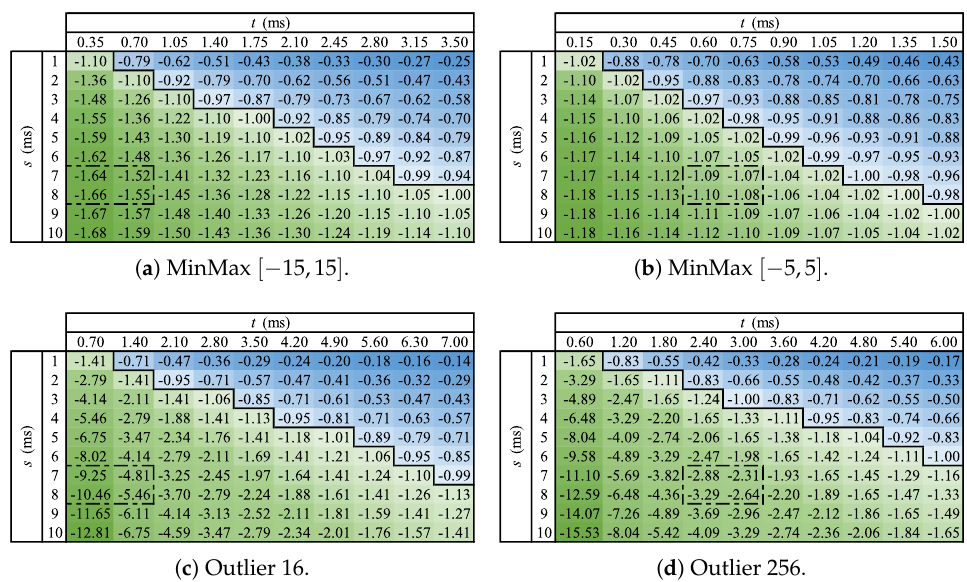
Figure 13. Slope simulations for each test case using execution time as the cost.